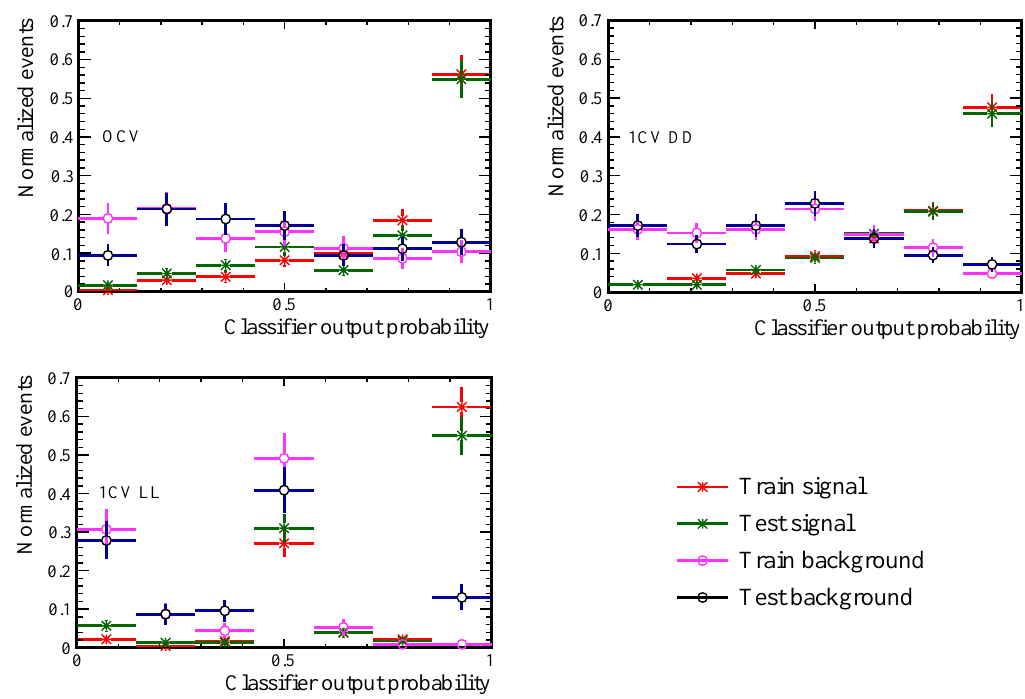
Figure 1: Output probability of the classifier for the different topologies. Upper left: 0CV , upper right: 1CV DD , lower 1CV LL